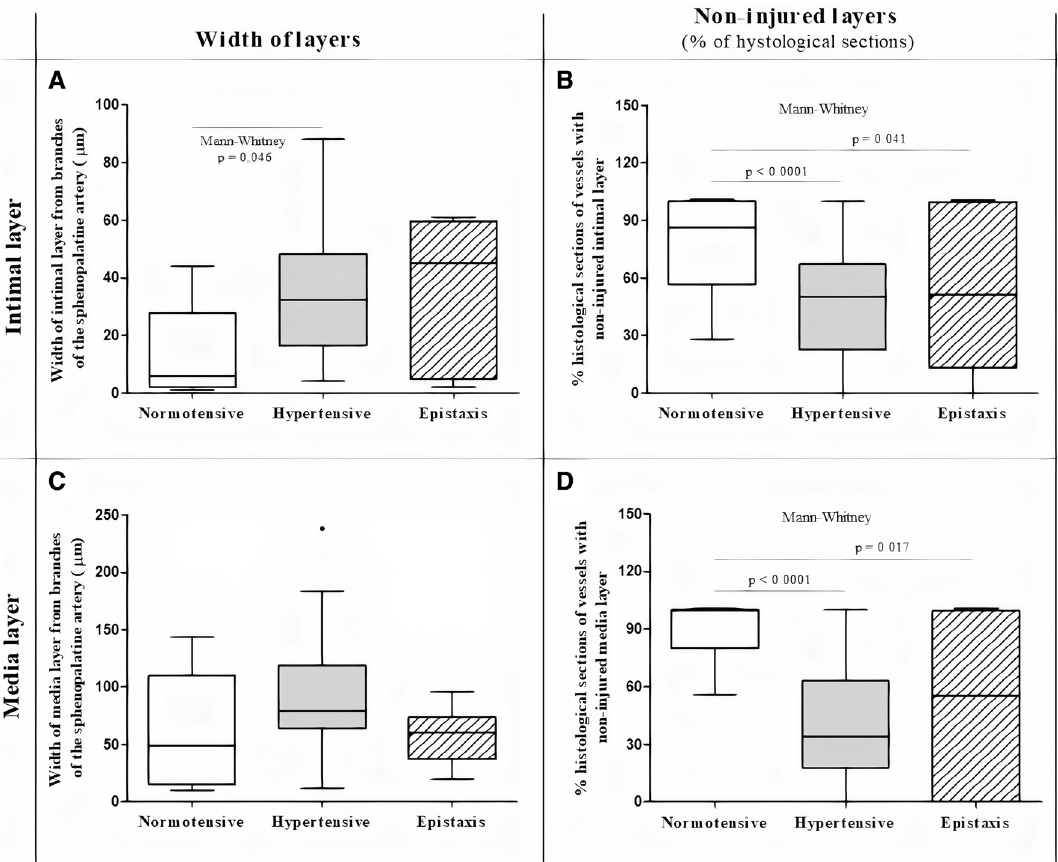
Figure 2. Width of intima ( A ) or media layer ( B ) and percentage of non-injured intima ( C ) or media layer ( D ) of sphenopalatine branches from normotensive, hypertensive and epistaxis groups. Results analyzed by t-test or Mann–Whitney showed that the width of intima to normotensive was lower than hypertensive ( p = 0.046), but not to the epistaxis ( p > 0.05); the width of media did not differ between three groups ( p > 0.05). The normotensive presented higher % of non-injured intima ( C ) or media ( D ) when compared to hypertensive or epistaxis group ( p < 0,05); hypertensive and epistaxis group did not differ in all analyzes (Unpaired t test, p > 0.05). Results are represented as medians, quartiles, maximum and minimum and extreme values (Prism 5.0, GraphPad, Software, Inc., San Diego, CA, USA: https:// www. graph pad. com/ scien tific- softw are/